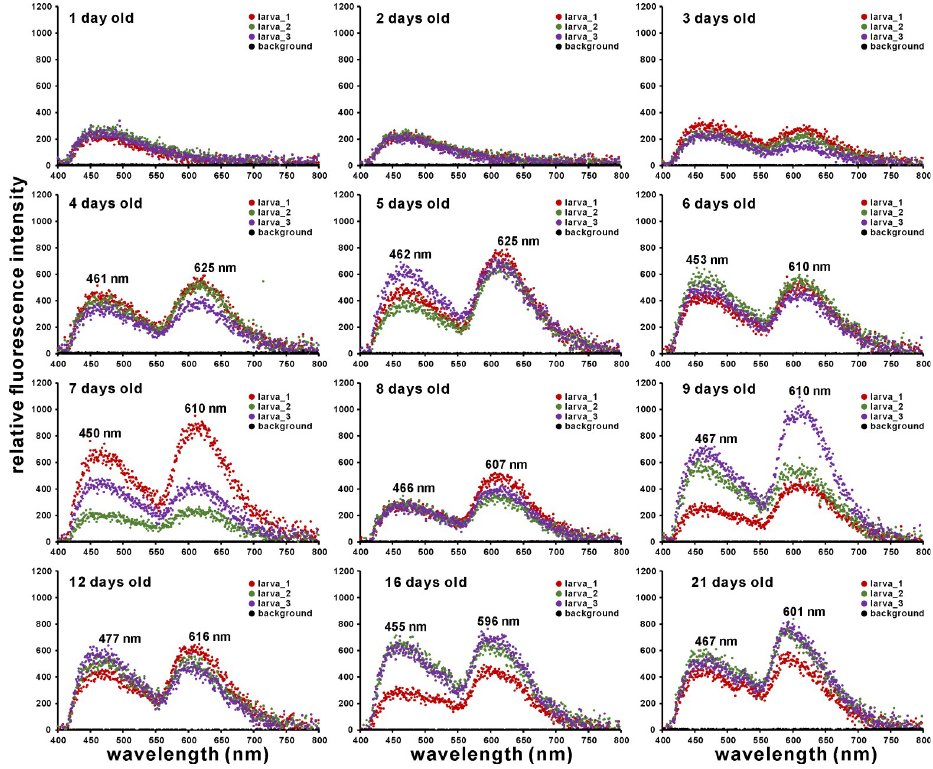
Fig 6. Fluorescence spectrum of A . tenuis larvae under UV-A excitation (Ex. 330–385 nm, Em. � 420 nm). Peak wavelength at which the maximum intensity was recorded is shown in each